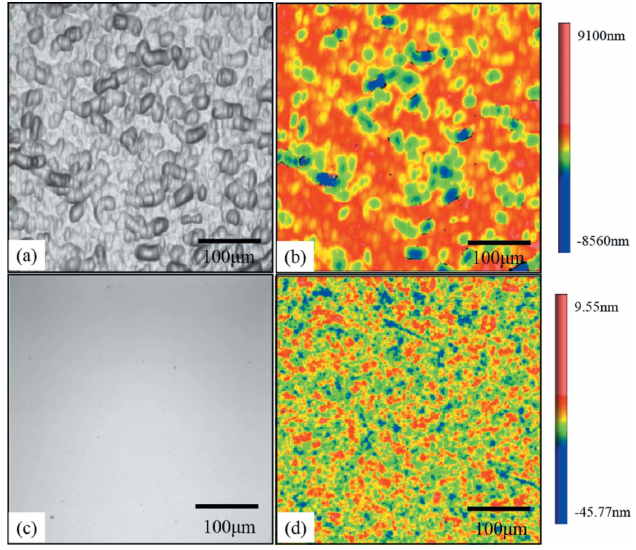
Figure 4 ( a ) Optical micrograph of the WCE CC. ( b ) The corresponding roughness